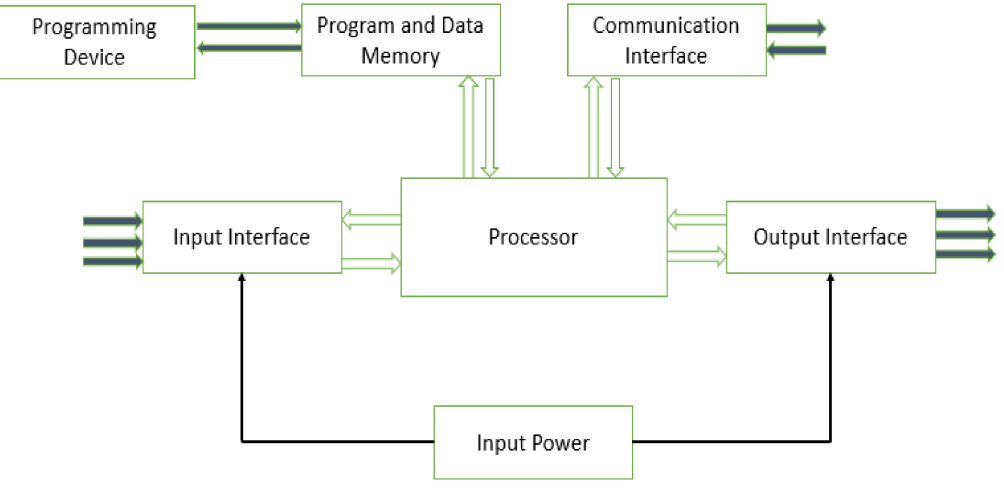
Figure 5. PLC basic structure.